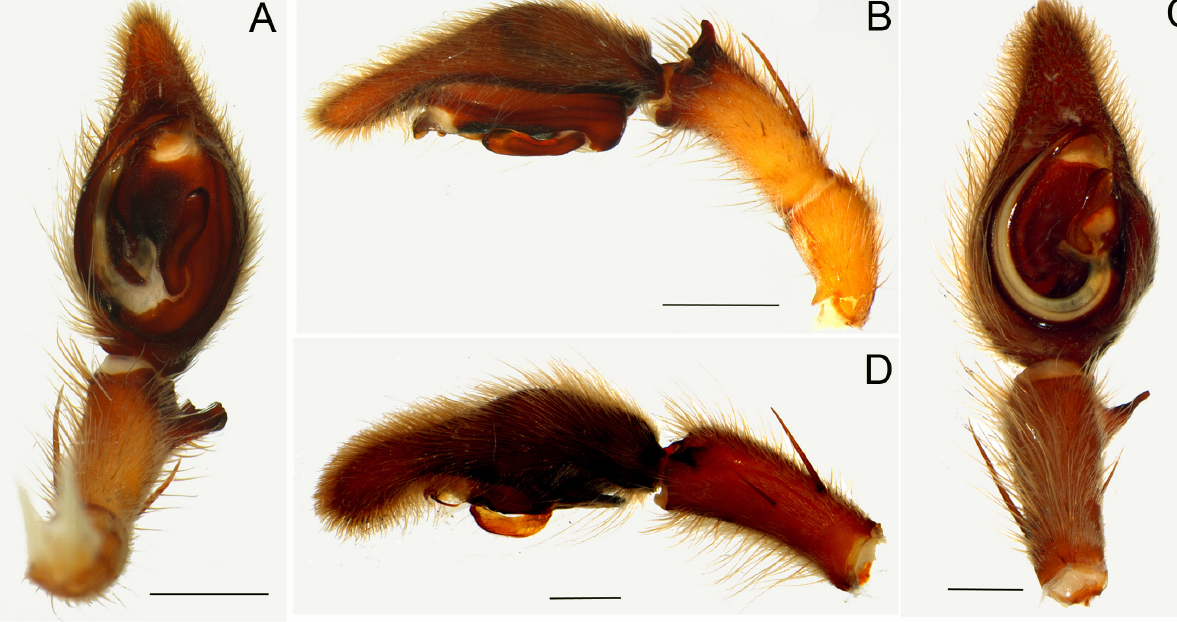
Fig. 15. Male palp. — A–B . Afroneutria quadrimaculata sp. nov. A . Ventral view. B . Retrolateral view. — C–D . Afroneutria erythrochelis (Simon, 1876) comb. nov. C . Ventral view. D . Retrolateral view. Scale bars = 1